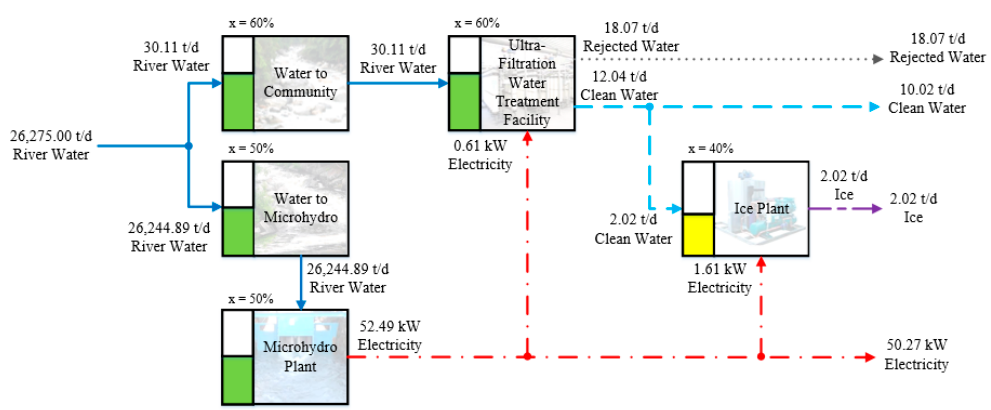
Figure 4. The optimal configuration of the polygeneration system of case study 1 under D = 0.50 (or 50%).